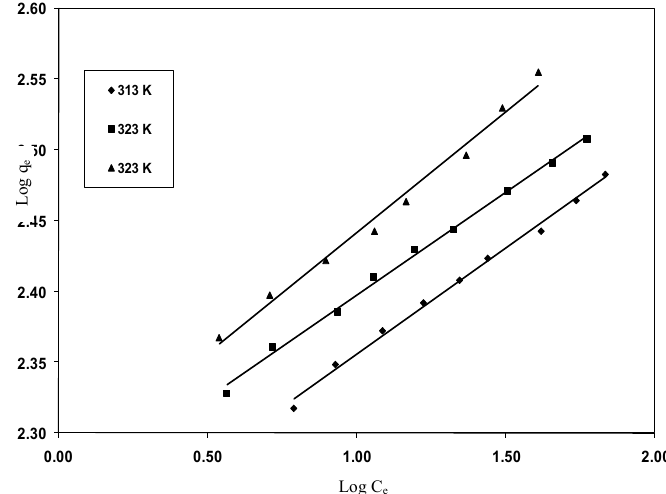
Figure 12. Freundlich isotherm for the adsorption AG 25 on to ACC at various temperature. Tempkin